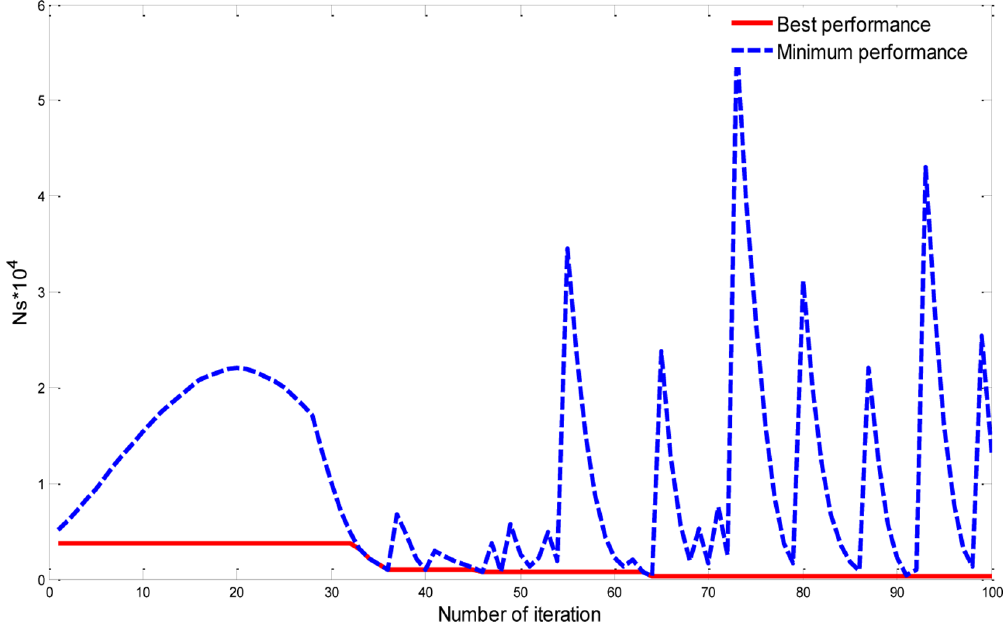
Figure 3. The global best performance and minimum performance of the algorithm per iteration in terms of Ns . doi:10.1371/journal.pone.0066080.g003 PLOS ONE |